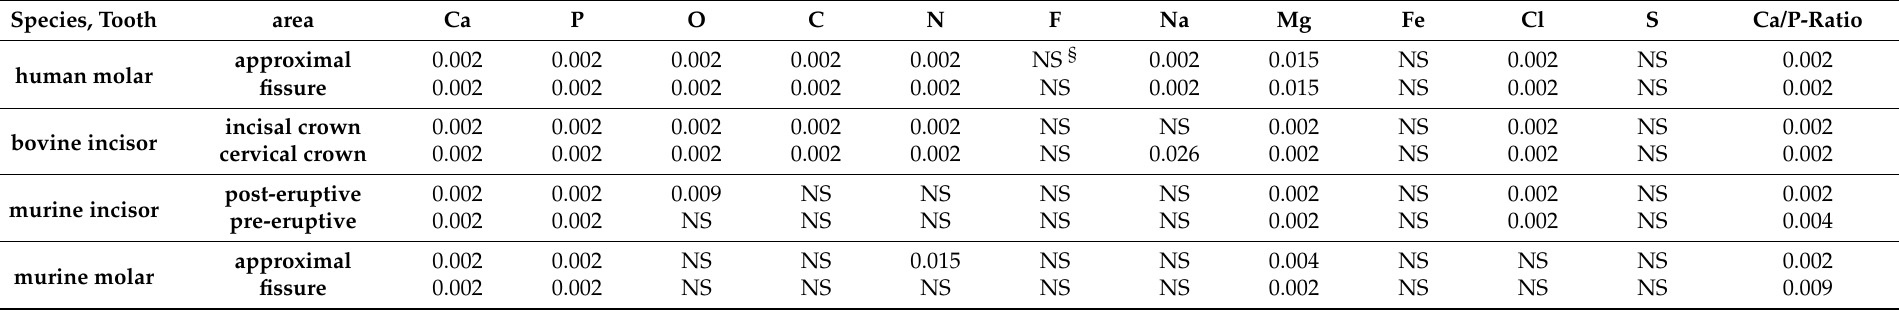
Table 3. p -values from pairwise tests between enamel and dentin in each measurement area for all elements and the Ca/P-Ratio (results in Figure 6). Species, Tooth